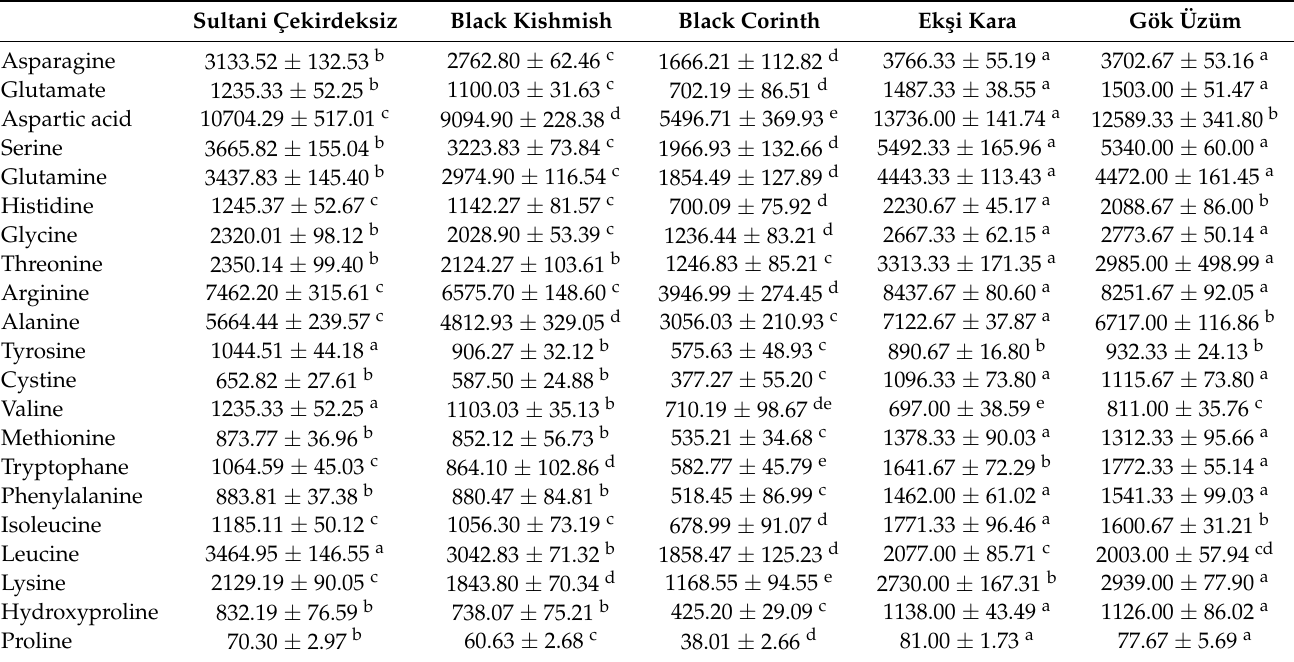
Table 7. Amino acid contents (mg 100g − 1 ) of two stenospermocarpy varieties (Sultani Çekirdeksiz and Black Kishmish); one parthenocarpic variety (Black Corinth) and two seeded varieties (Ek¸si Kara and Gök Üzüm) in 2020